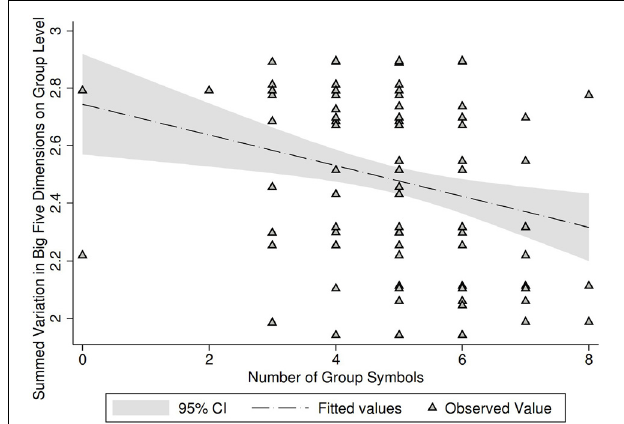
FIGURE 2 | Association of group variation in Big Five and group performance. Personality measured as standard deviation at the level of ego’s group membership. Group performance/identification measured as number of group symbols acquired by each group member. Regression controlling for age and gender.